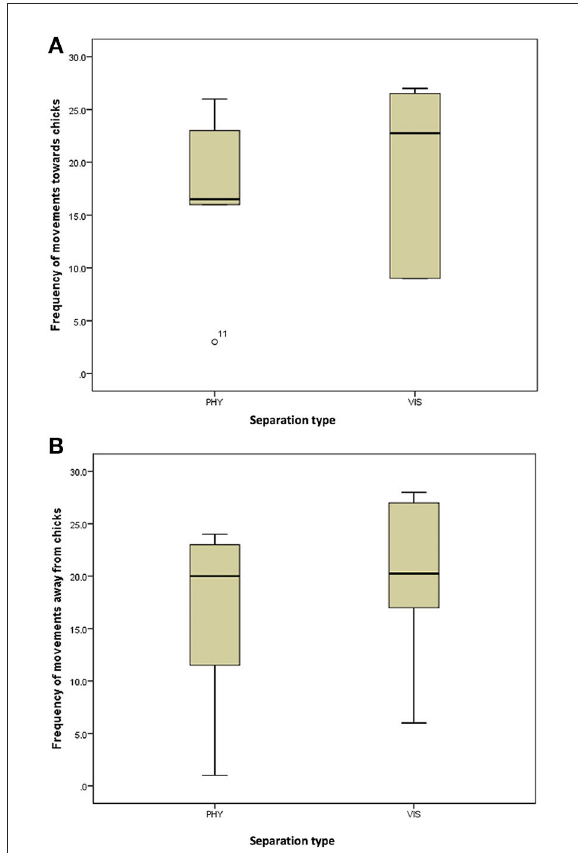
FIGURE3 (A) Frequency of movement of the mother hens toward their chicks when subjected to 10-min physical (PHY) or visual (VIS) separation. (B) Frequency of movement of the mother hens away from their chicks when subjected to 10-min physical (PHY) or visual (VIS) separation.